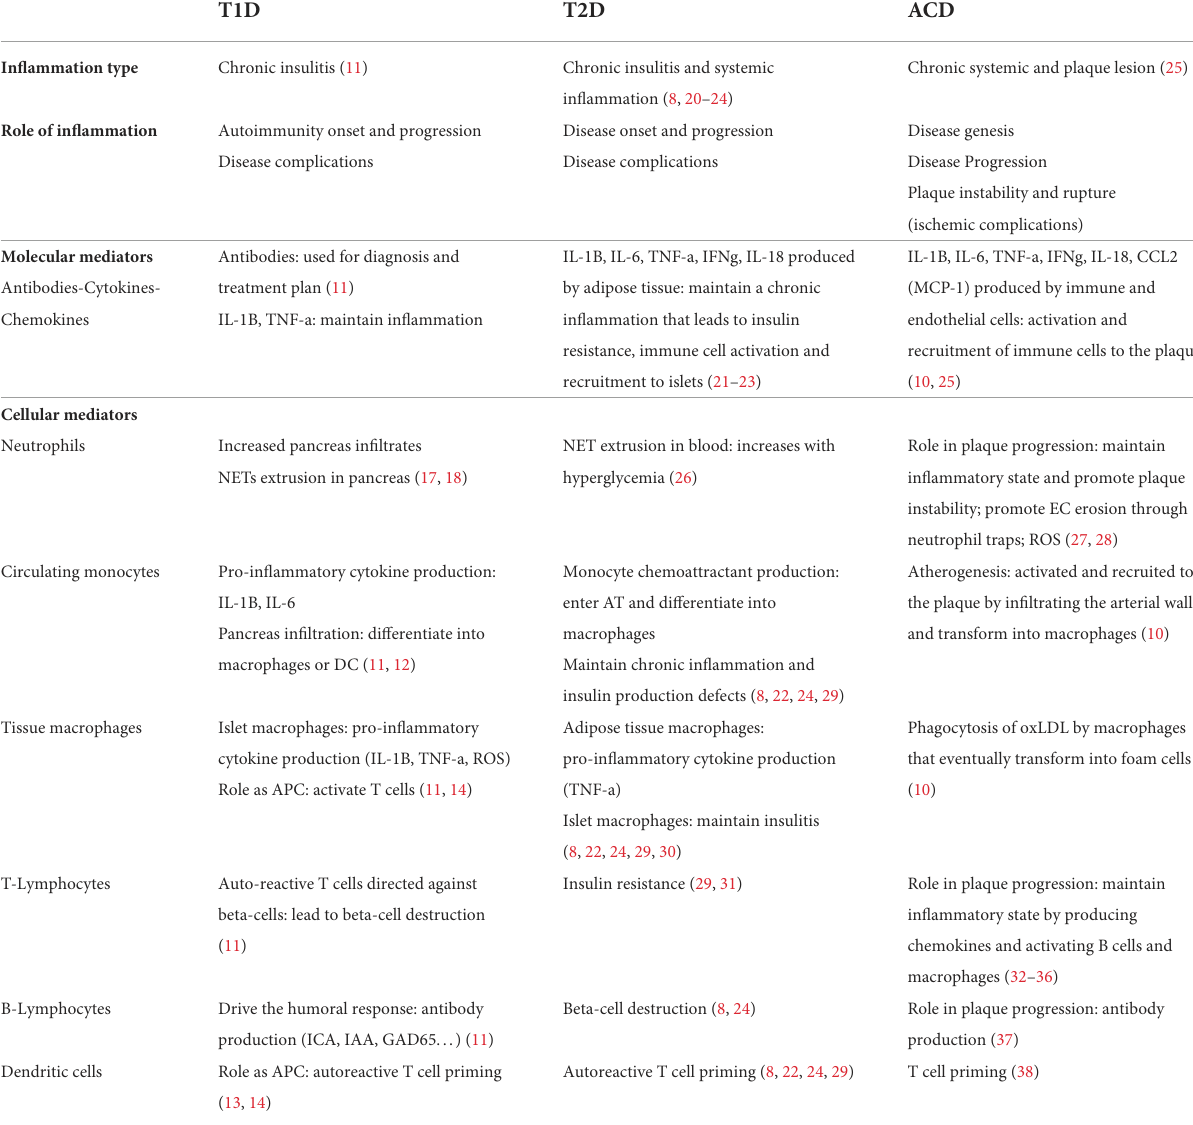
TABLE 1 Common immune cell function and inflammatory mechanisms between diabetes mellitus and atherosclerosis cardiovascular